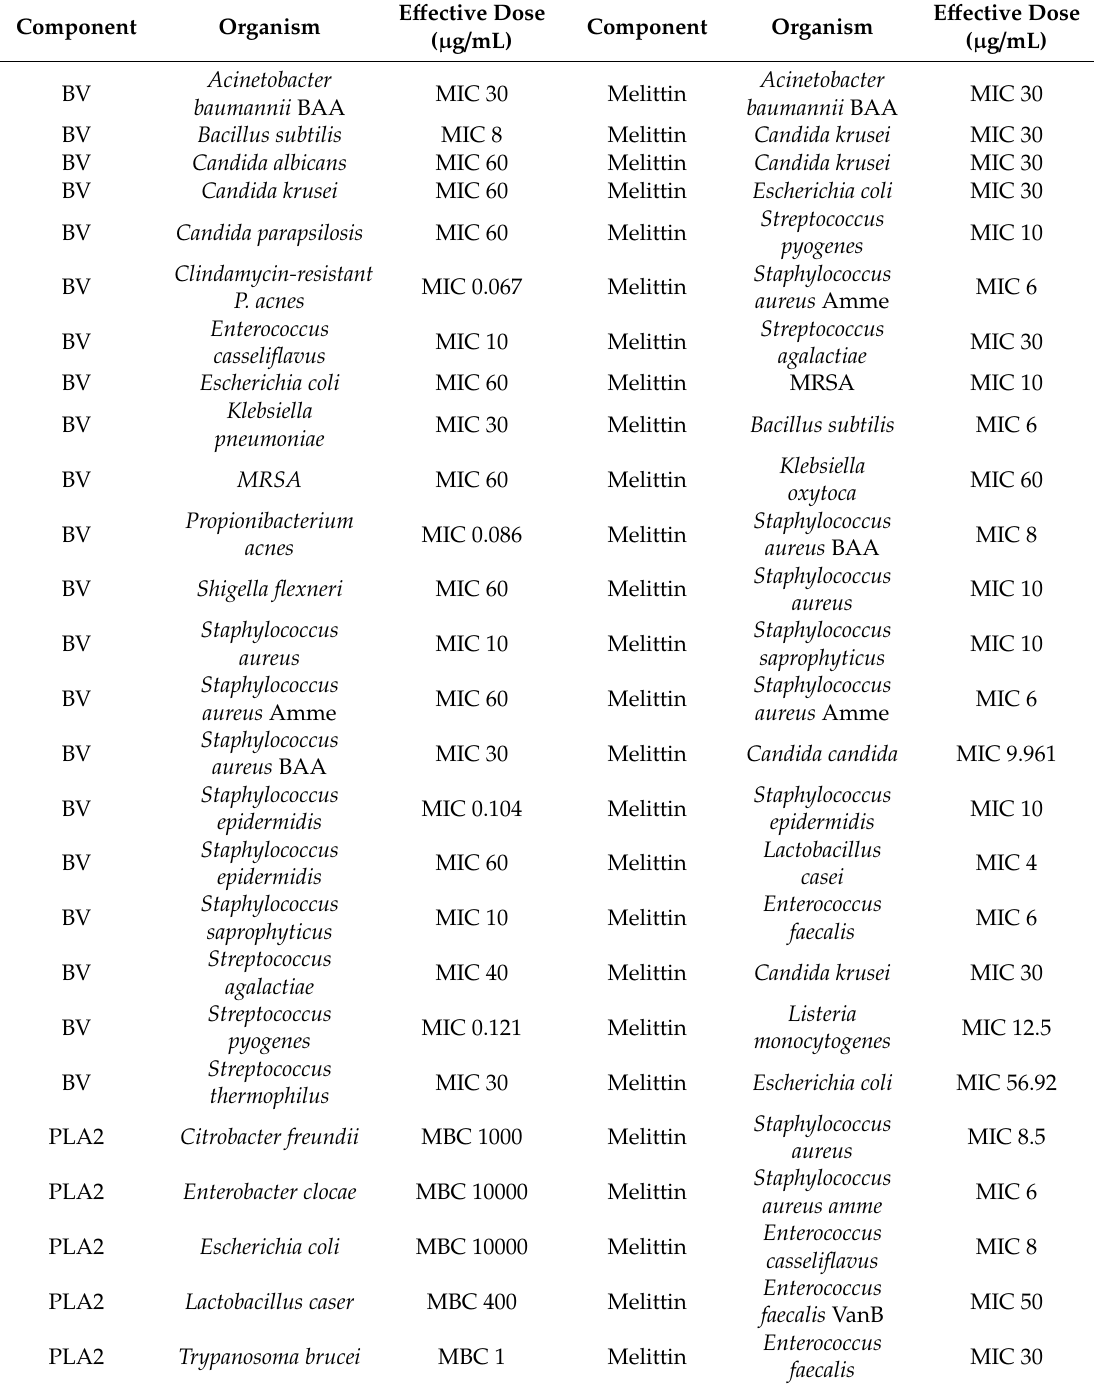
Table 3. Antimicrobial activity of biological compounds. Modified from [1] and